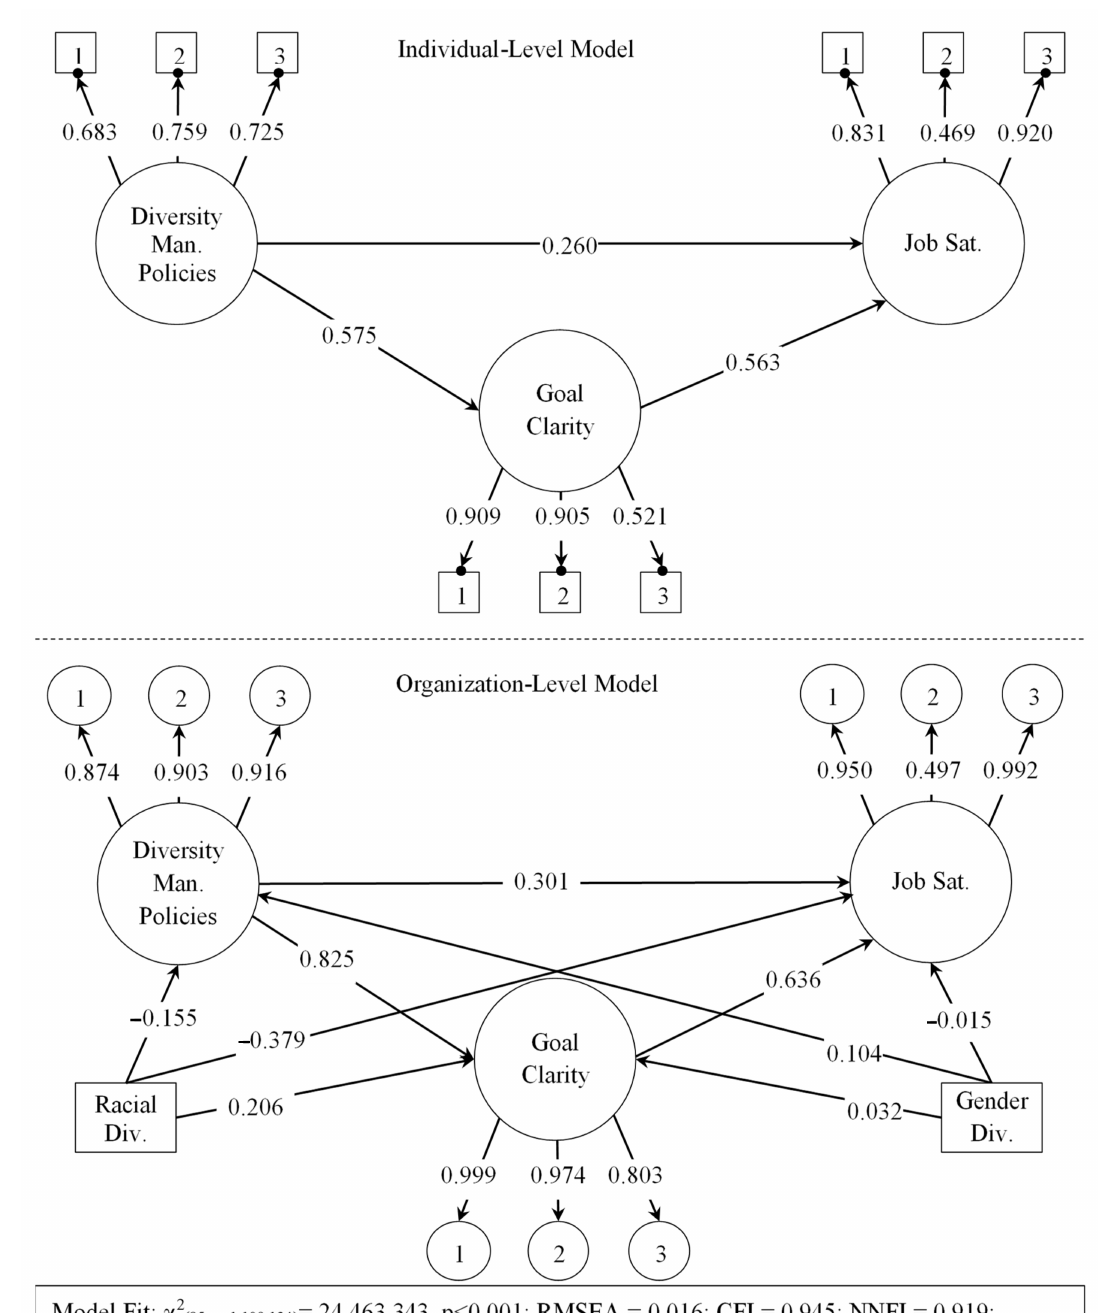
Figure 1. Multi-level